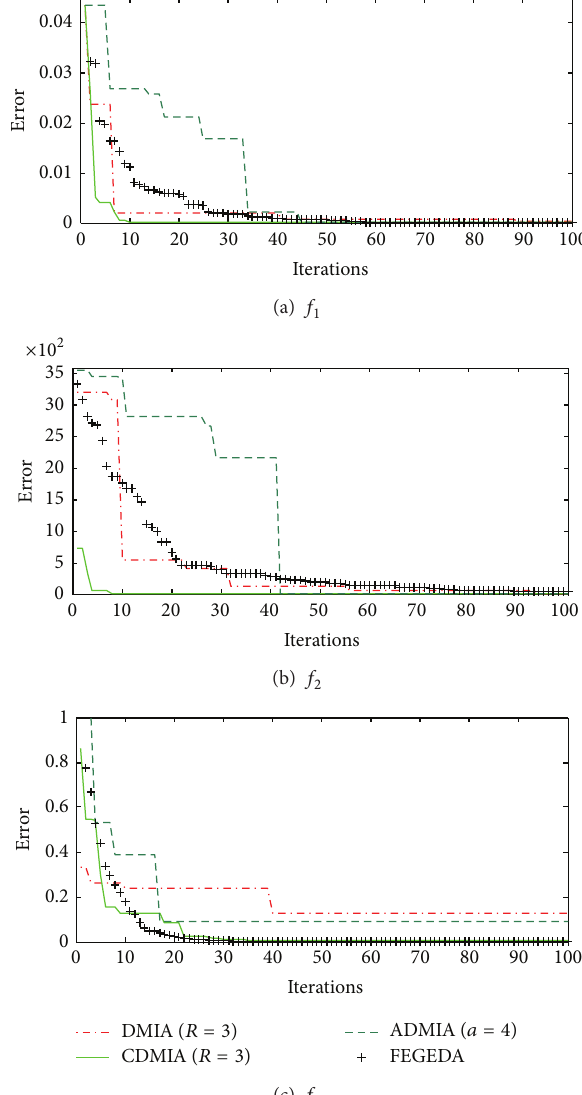
Figure 8: Comparisons of convergent